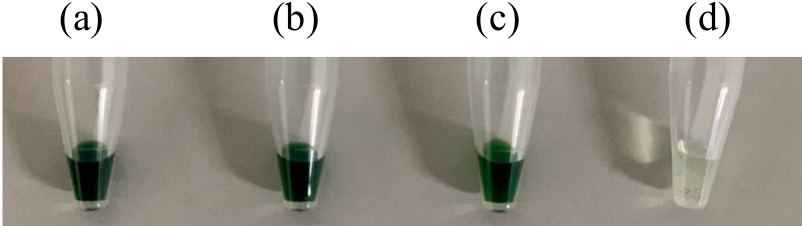
Figure 3. Comparison of the solution states of the PSI/DKDKC 12 K ‐ PA n conjugates and the reference supernatant solution of PSI. The PSI/DKDKC 12 K ‐ PA n conjugates were the isolated ones by removement of the unbound DKDKC 12 K ‐ PA n by gel permeation chromatography. The reference supernatant solution of PSI was prepared by decrease in β‐ DDM concentration less than 0.00001 wt% by ultrafiltration. ( a ) PSI/DKDKC 12 K ‐ PA 5 conjugate, ( b ) PSI/DKDKC 12 K ‐ PA 7 conjugate, ( c ) PSI/DKDKC 12 K ‐ PA 18 conjugate, ( d ) the reference supernatant solution of PSI sample.